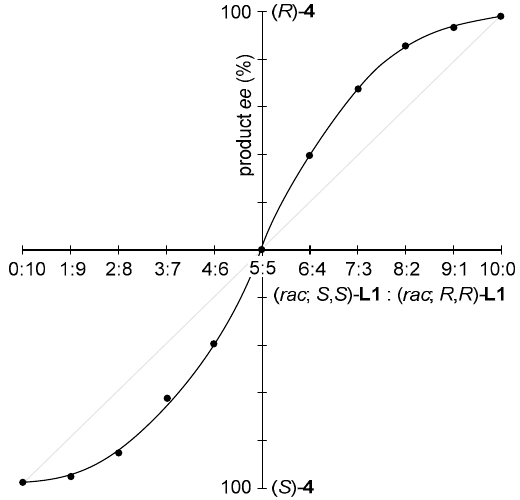
Figure 5. Chiral amplification in the conjugate addition reaction of 3 using ( rac ; S,S )- L1 and ( rac ; R,R )-